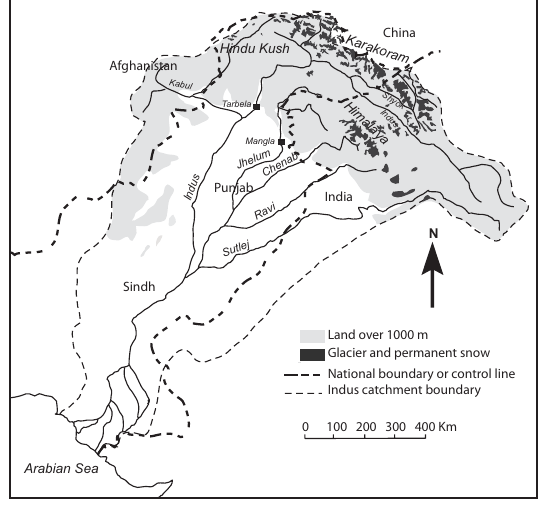
Fig. 1 The Indus Basin 735 Fig. 1. The Indus